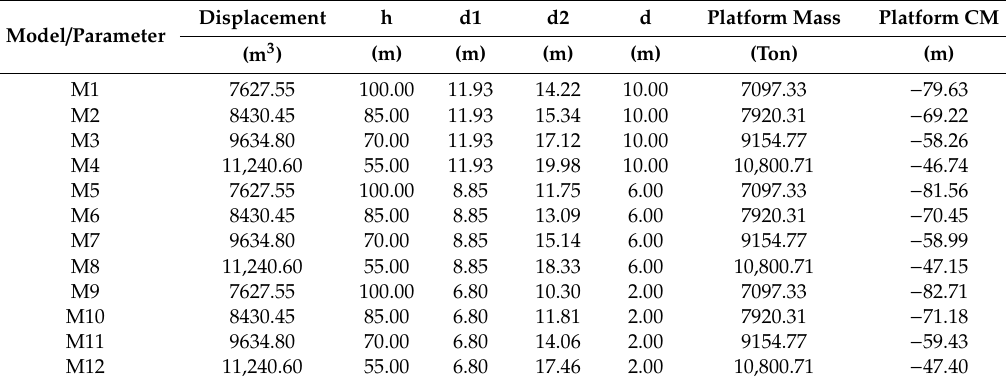
Figure 8. The trend of the mass distribution for steel and ballast mass. Table 5. The main parameters for the 12 candidate platform